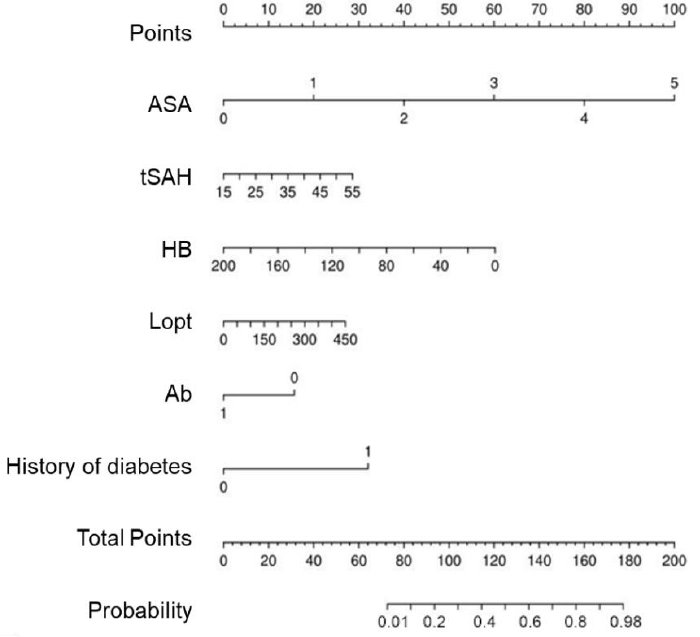
Figure 5. Development of the prediction nomogram. The EVD-associated infection risk nomogram